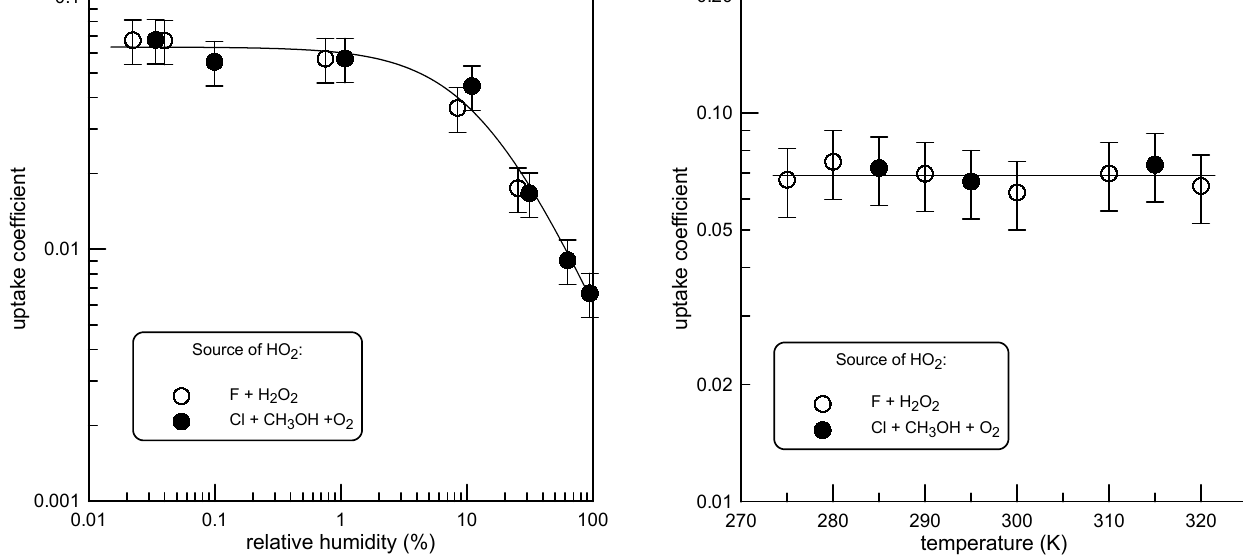
Fig. 7. Temperature dependence of the uptake coefficient of HO 2 on ATD: P = 1Torr, T = 275–320K, RH = 0.04%, [HO 2 ] 0 ≈ 10 12 moleculecm − 3 . The data were obtained with two sources of HO 2 radicals: reactions F + H 2 O 2 (open symbols) and Cl + CH 3 OH + O 2 (filled